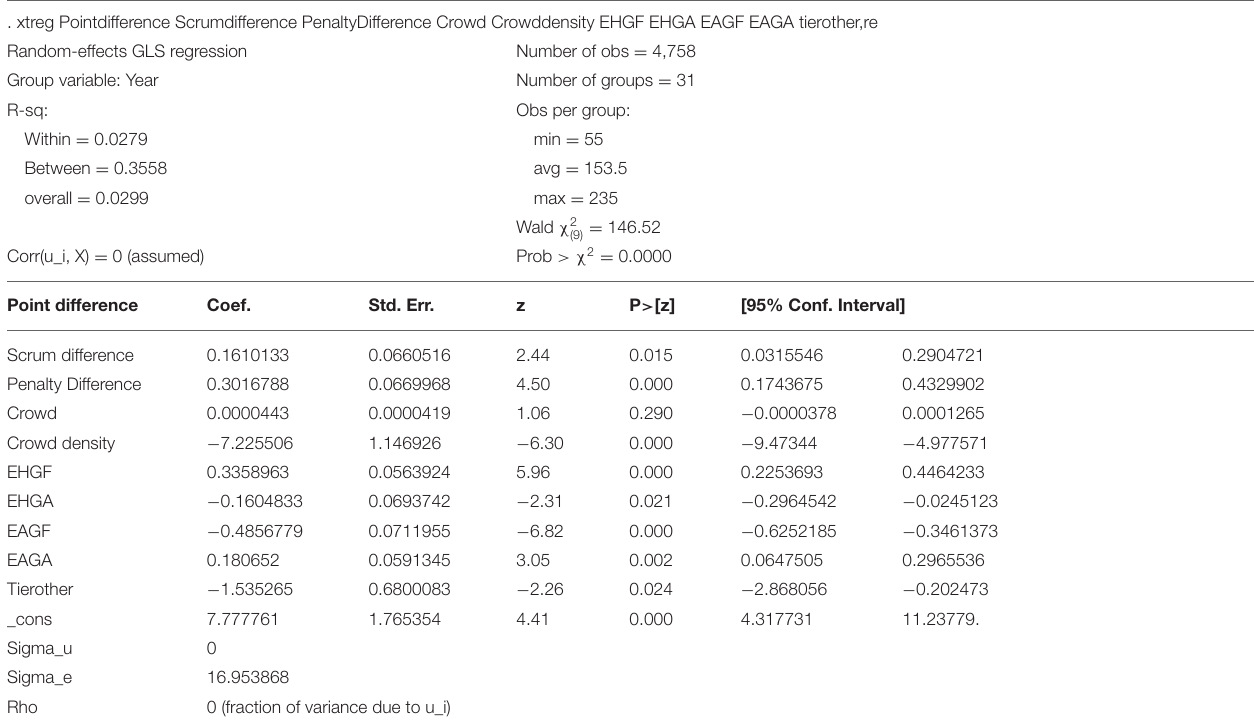
TABLE 4 | Random effects regression—tier 1 referees against an amalgamation of tiers